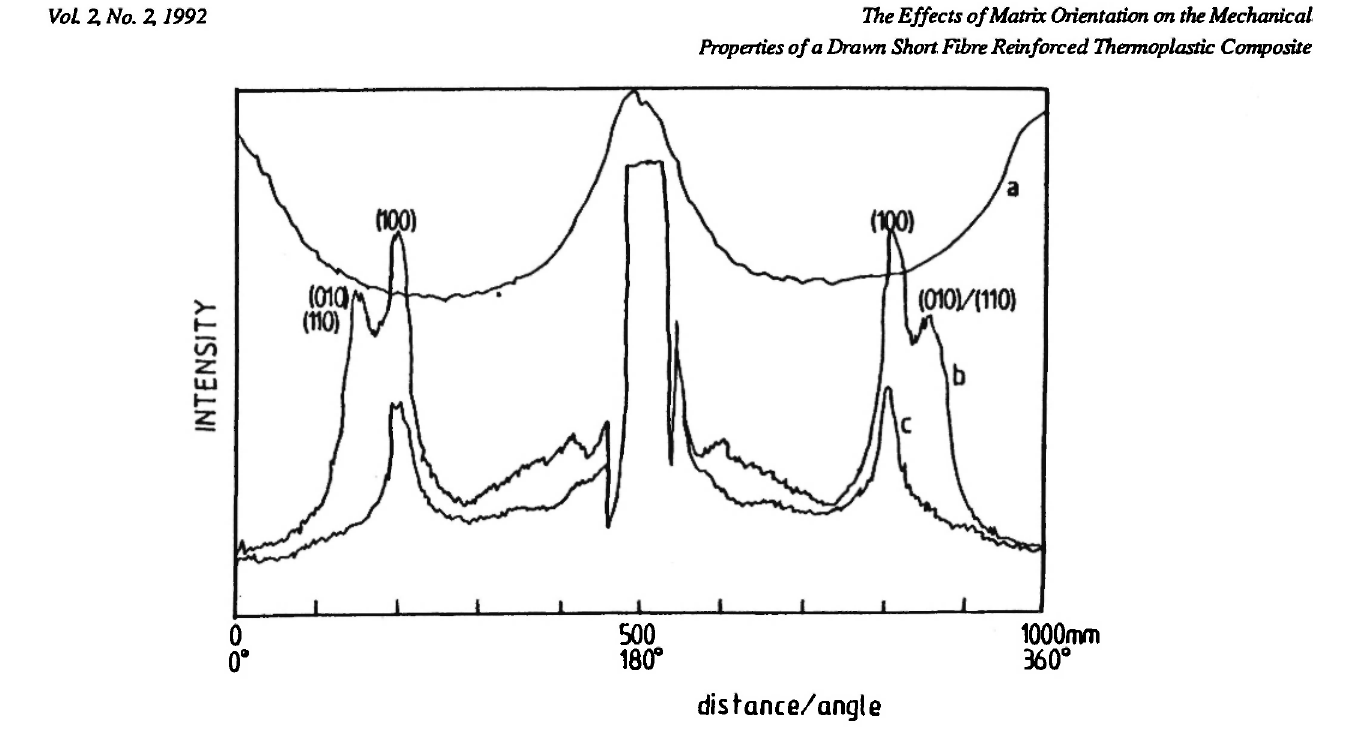
Fig. 8: Typical microdensitometry scans of a drawn 5% CFR Nylon-6,6 composite drawn at 175°C to draw ratio of 2.5 showing linear intensity CLINT) along the equator (curve (c)), meridian (curve (b)) and azimuthal (AZIM) (curve (a)) through the (010)/(110) reflection.